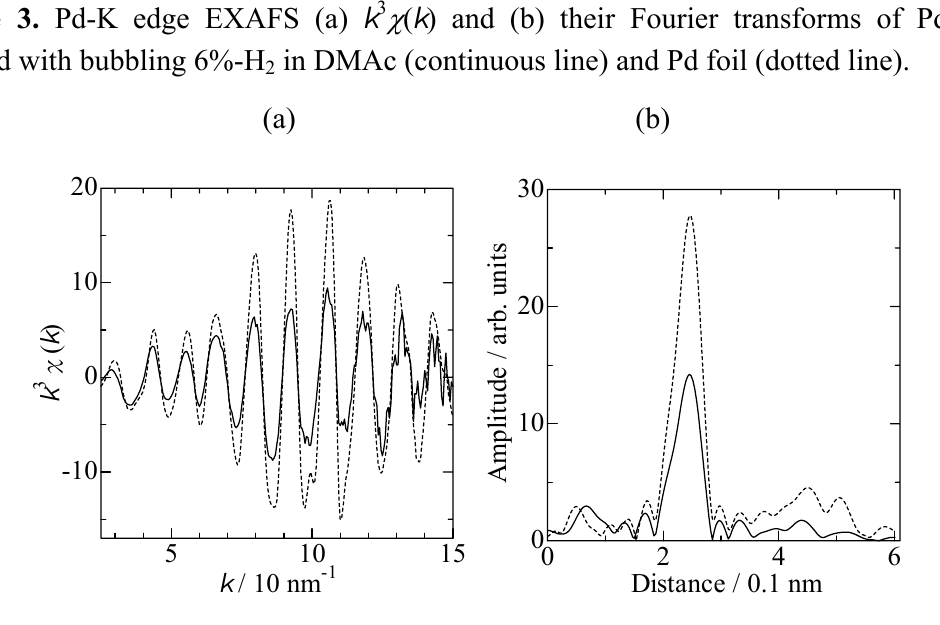
Table 2. Strength of Brønsted acid sites in USY zeolites determined by NH